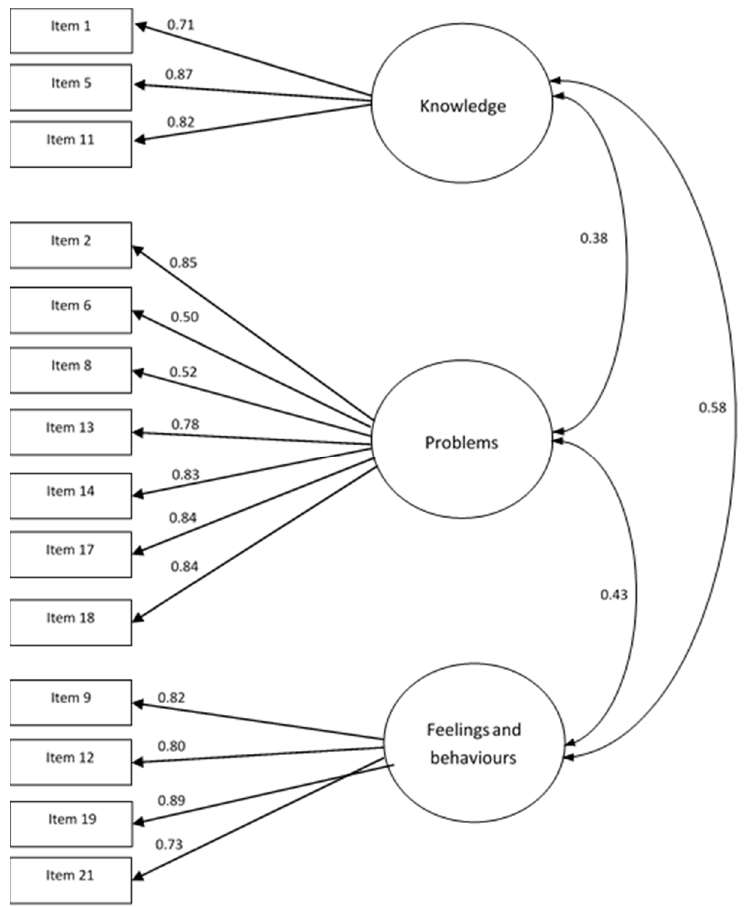
Figure 1. Standardized factor loadings of the three-factor model for the total sample after confirmatory factor analysis.